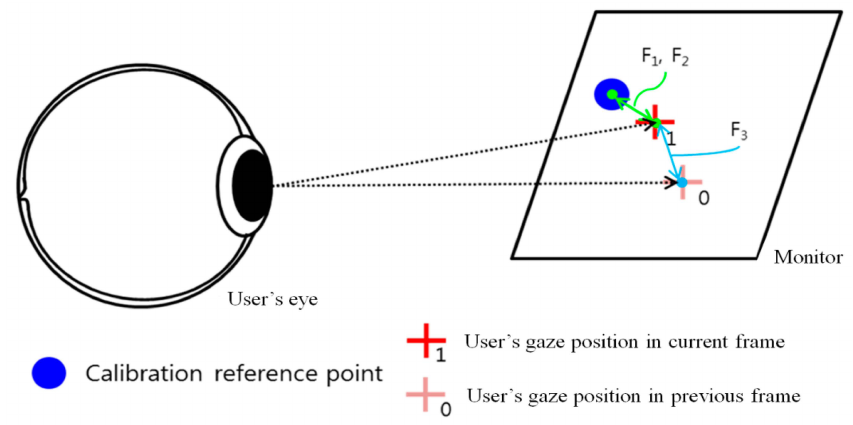
Figure 7. The feature values that can be obtained during the calibration